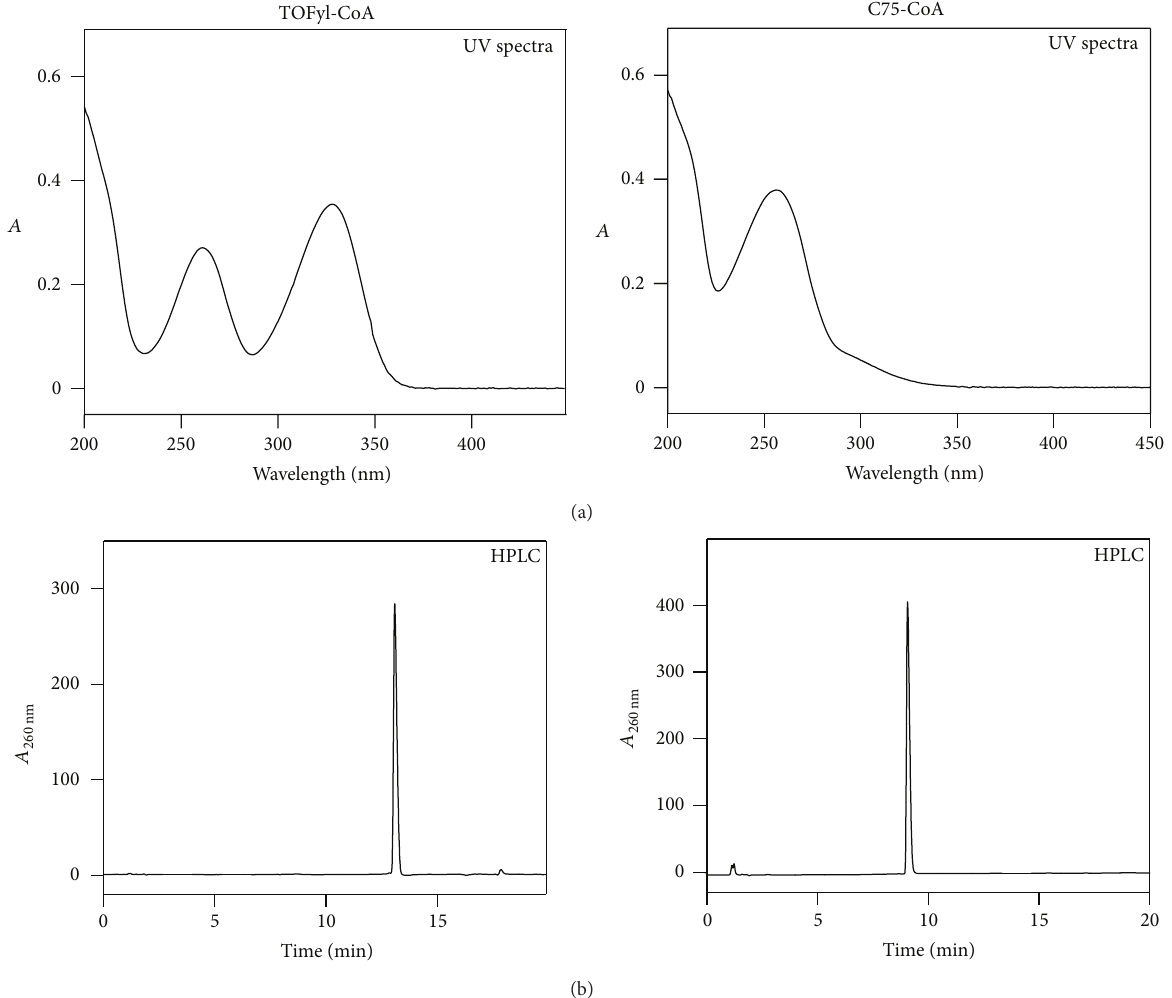
Figure 4: UV spectra and HPLC analysis of TOFA-CoA and C75-CoA. Ultraviolet spectra of TOFyl-CoA and C75-CoA were obtained with a Cary 100 Scan UV-Visible Spectrophotometer (Varian, Inc., Palo Alto, CA, USA) as described in Methods. TOFyl-CoA and C75-CoA were purified by HPLC as previously described [15]. When the final purified TOFyl-CoA and C75-CoA were reapplied to the HPLC column, representative HPLC runs detected only single absorbance peaks at 260 nm for TOFyl-CoA and C75-CoA with retention times of 13 and 9min,